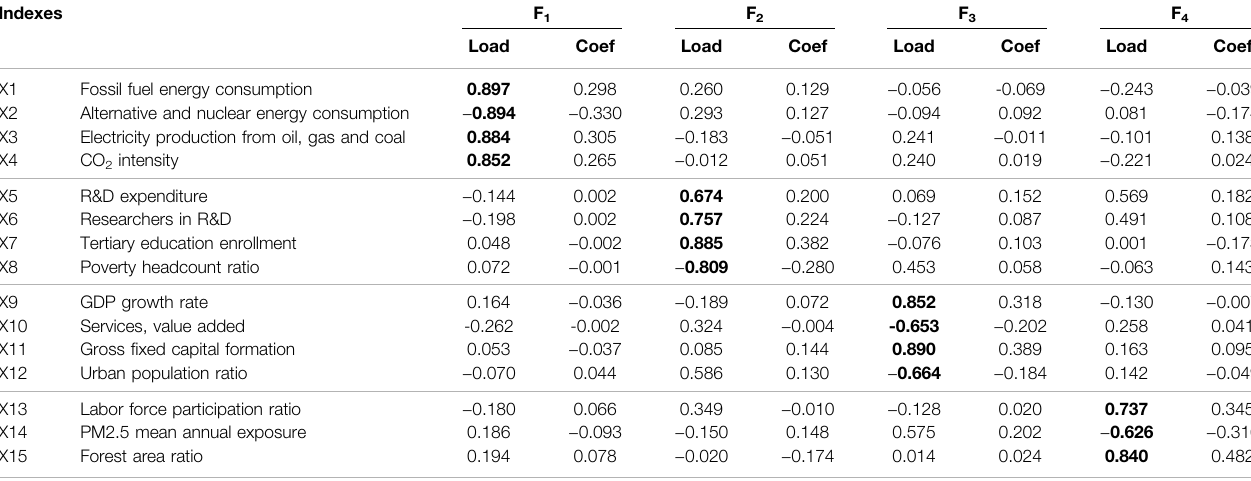
TABLE 4 | Rotated factor loadings matrix and component score coef fi cient matrix. Indexes